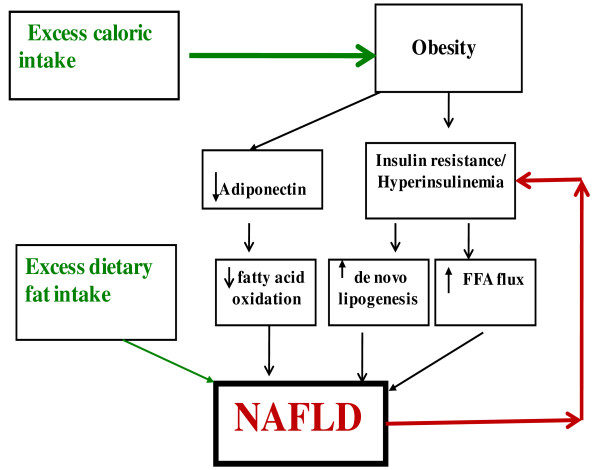
Diagram of potential sources of and mechanisms for the accumulation of fat in the liver. Excess caloric intake plays a central role for inducing obesity and thus contributing to insulin resistance. Obesity may additionally impact fat accumulation in the liver by decreasing adiponectin levels and insulin resistance contributes to NAFLD directly by increasing de novo lipogenesis and indirectly by increasing FFA flux to the liver via decreased inhibition of lipolysis. In addition, excess dietary fat intake directly could also contribute to a causal role in hepatic steatosis(modified from Kristina M. The Journal of Clinical Endocrinology & Metabolism 2006; 91: 4753-4761).